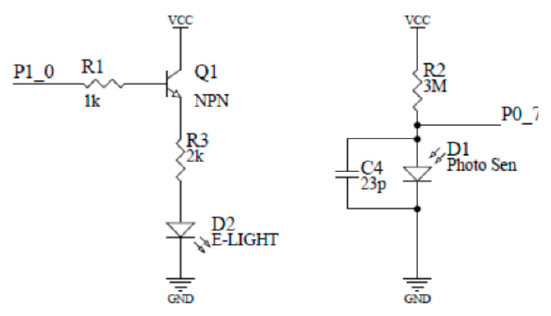
Figure 2. Infrared photodiode circuit.